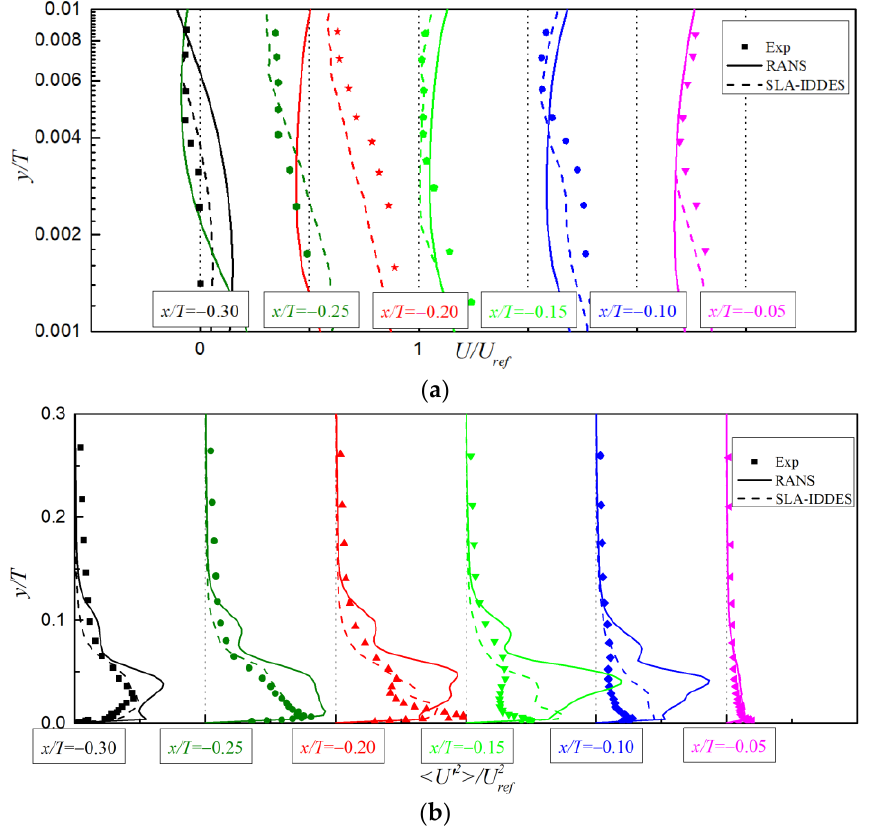
Figure 3. Mean velocity profile and Reynold stress in the leading edge region calculated using three different methods: ( a ) velocity profile and ( b ) Reynold stress.